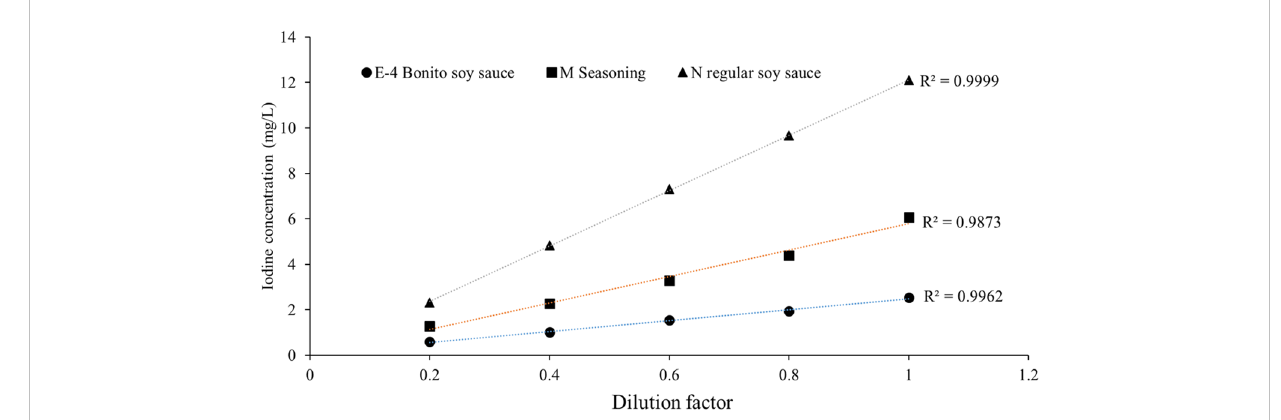
FIGURE 2 The linearity of iodine concentrations by serial dilution of three soy sauces.